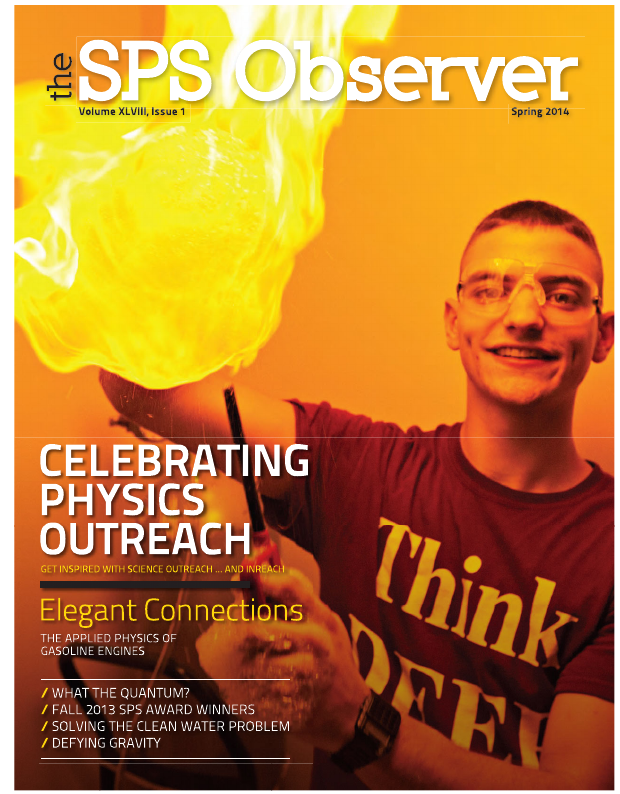
FIG. 3. The front cover of the SPS Observer features the DEEP student showing his demonstration at Texas A&M Physics & Engineering Festival [54]. Reproduced with permission from the SPS. Photo by Igor